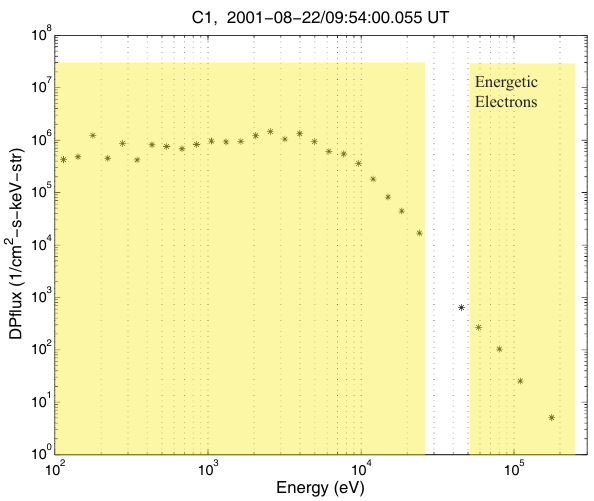
Figure 2. Differential particle flux as a function of energy for C1 on 22 August 2001 event at around 09:54:00UT. Yellow shaded regions mark the energy ranges for the energetic and lower energy electrons used to calculate the